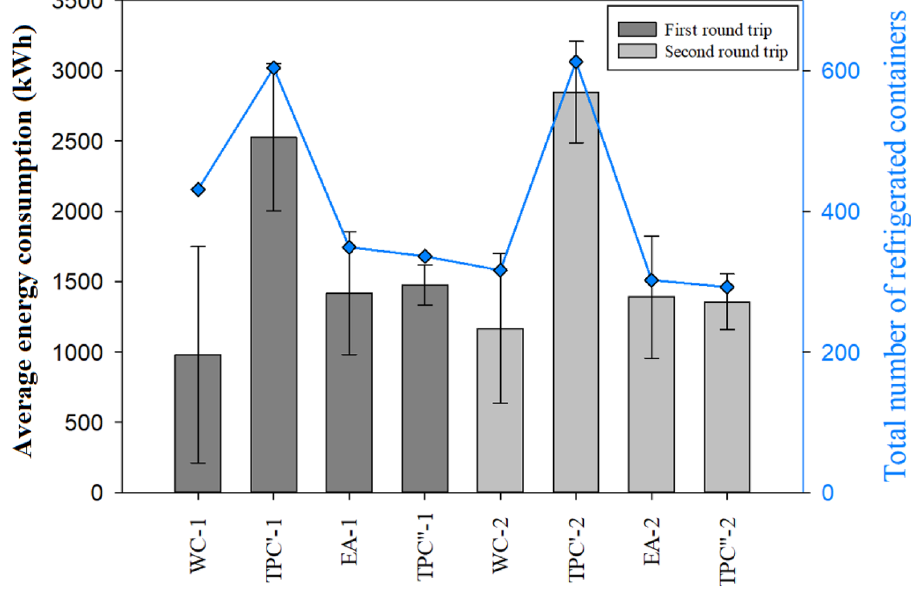
Figure 2. Average energy consumption and the number of refrigerated containers on board the vessel at the different voyage segments. WC west coast of the US, TPC ′ transpacific crossing to the East Asian ports, EA East Asia, TPC ″ transpacific crossing heading back to the Port of Los Angeles.